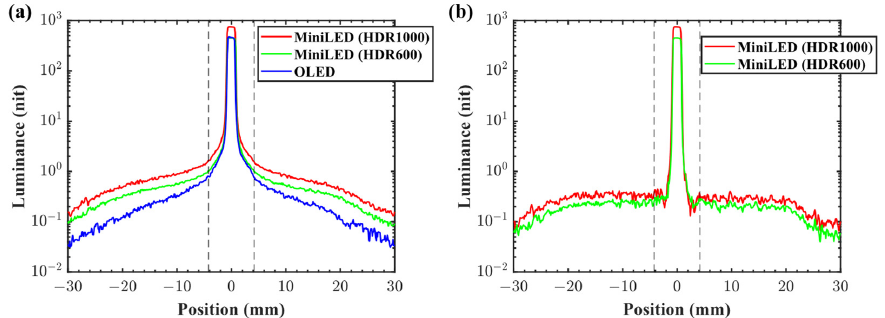
Figure 9. ( a ) Luminance profiles on the CMOS sensor for the mLCDs driven in the HDR1000 and HDR600 modes and the OLED display. ( b ) Real luminance profiles on the display screen for the mLCDs driven in the HDR1000 and HDR600 modes.